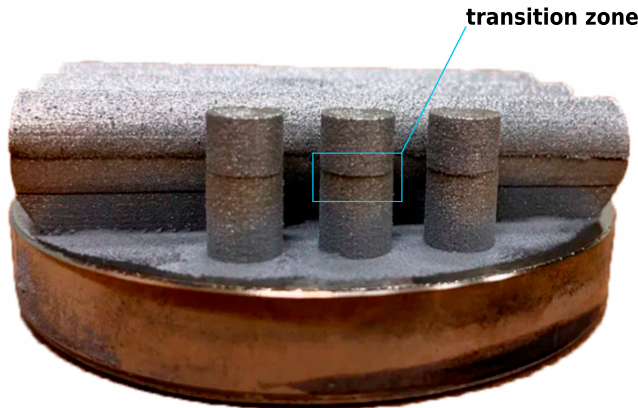
Figure 3. Photograph of the produced bimetallic samples showing the investigated transition zone between two alloys.